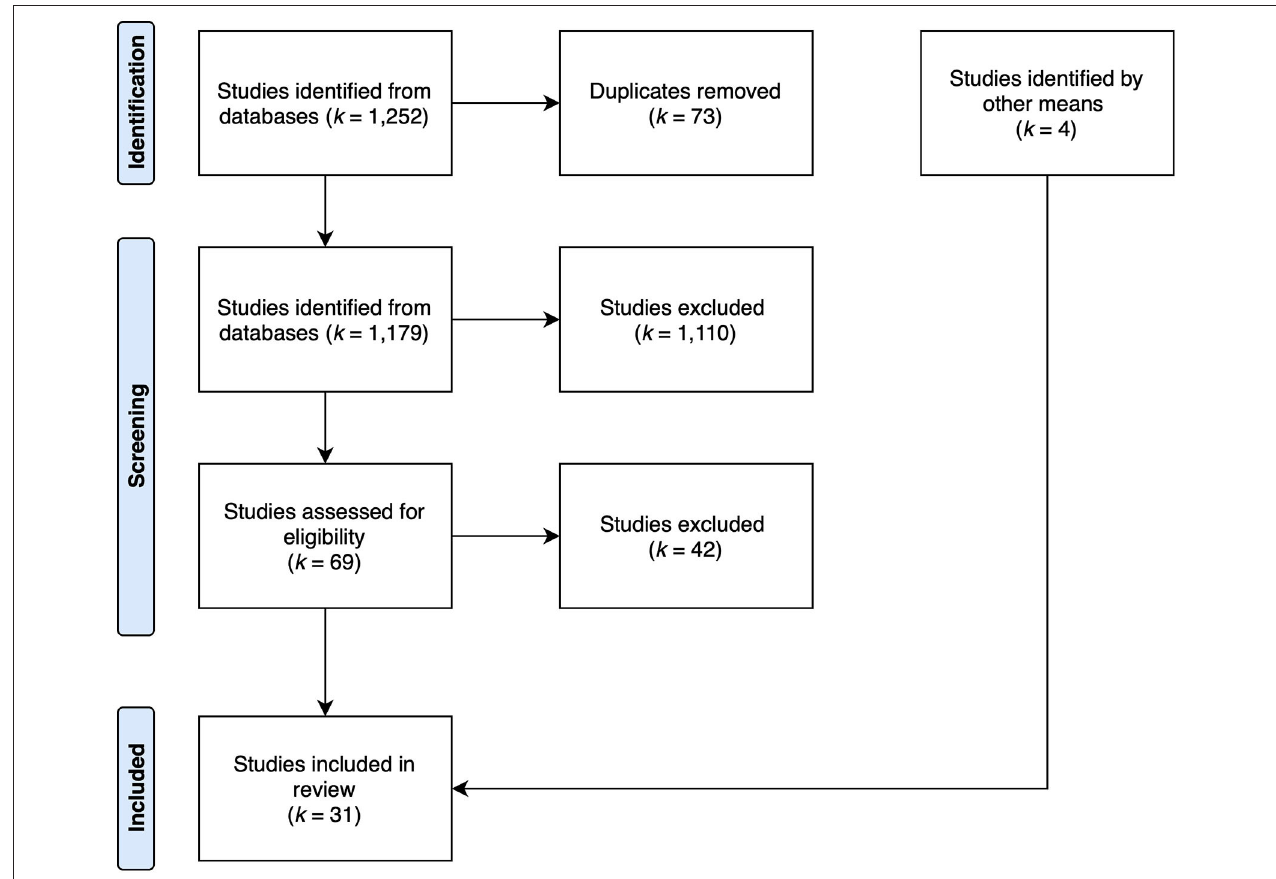
FIGURE 1 | Flow chart depicting the process of selection of paper for final analysis.